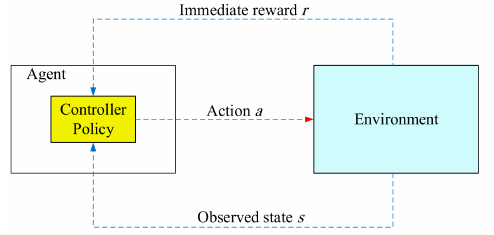
Figure 7. Traditional reinforcement learning